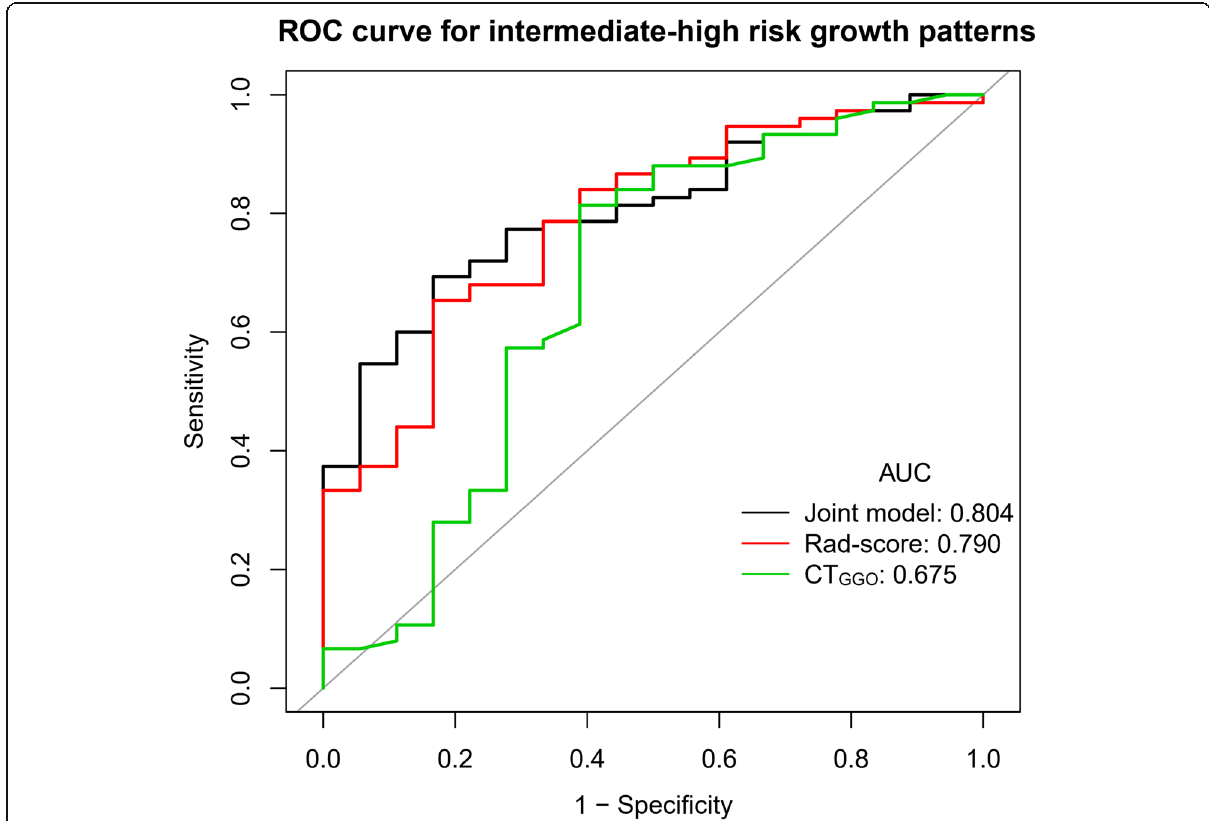
Fig. 5 Comparison of the ROC curves of three models in predicting intermediate-high risk growth patterns of IAC. Rad-score, radiomics signature score; CT GGO , attenuation value of the GGO component on CT